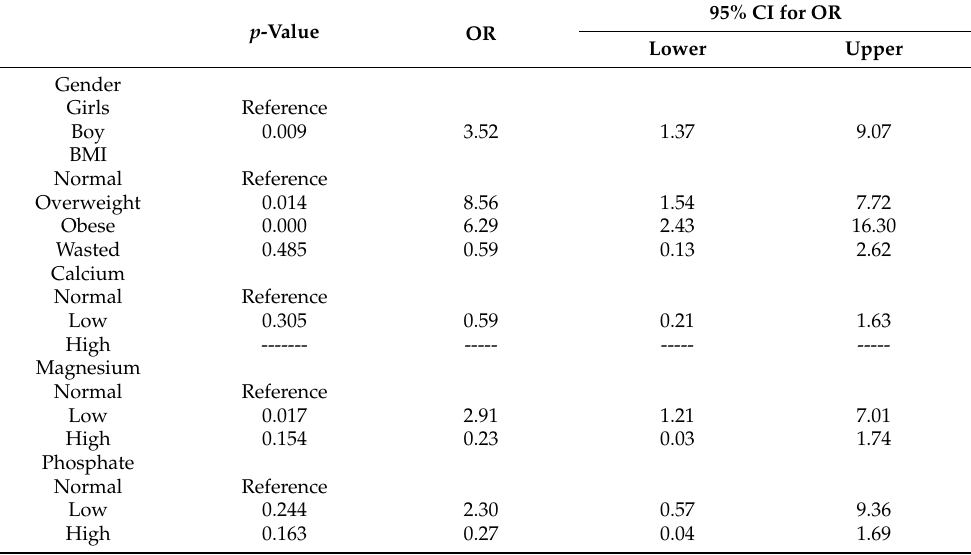
Table 4. Binary logistic regression of gender, BMI, calcium, magnesium and phosphate for R vitamin D